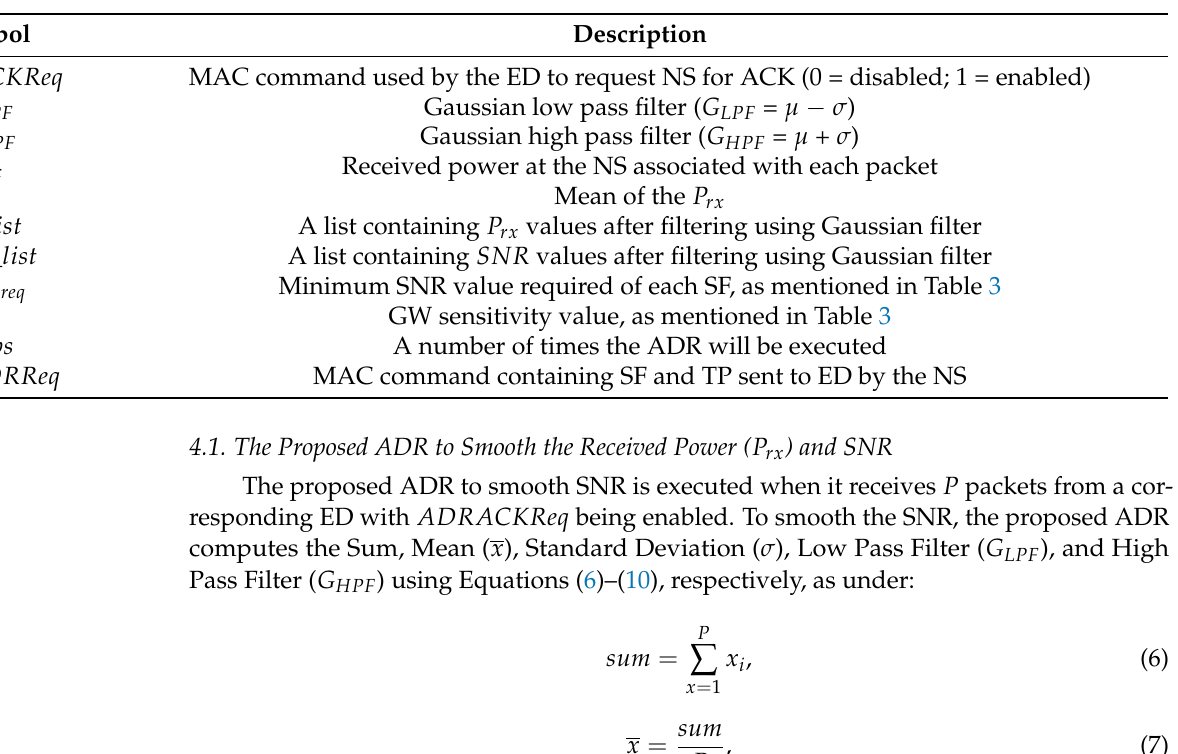
Table 4. Symbols used in the Proposed